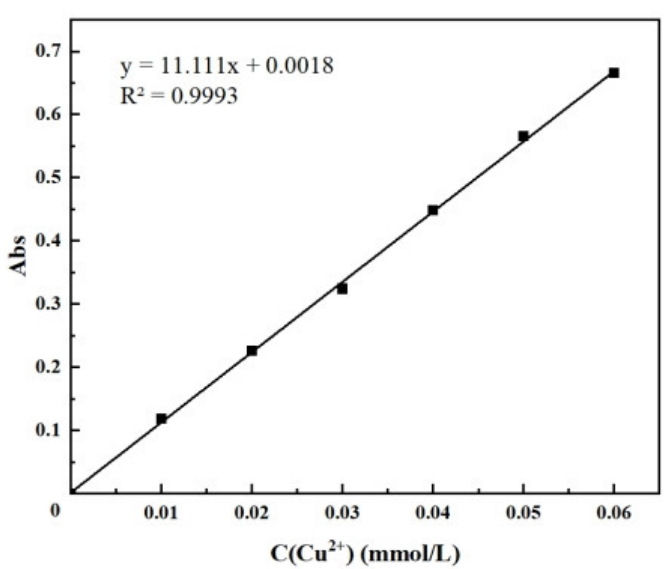
Figure 8. Absorbance standard fitting curve for Cu 2+ .